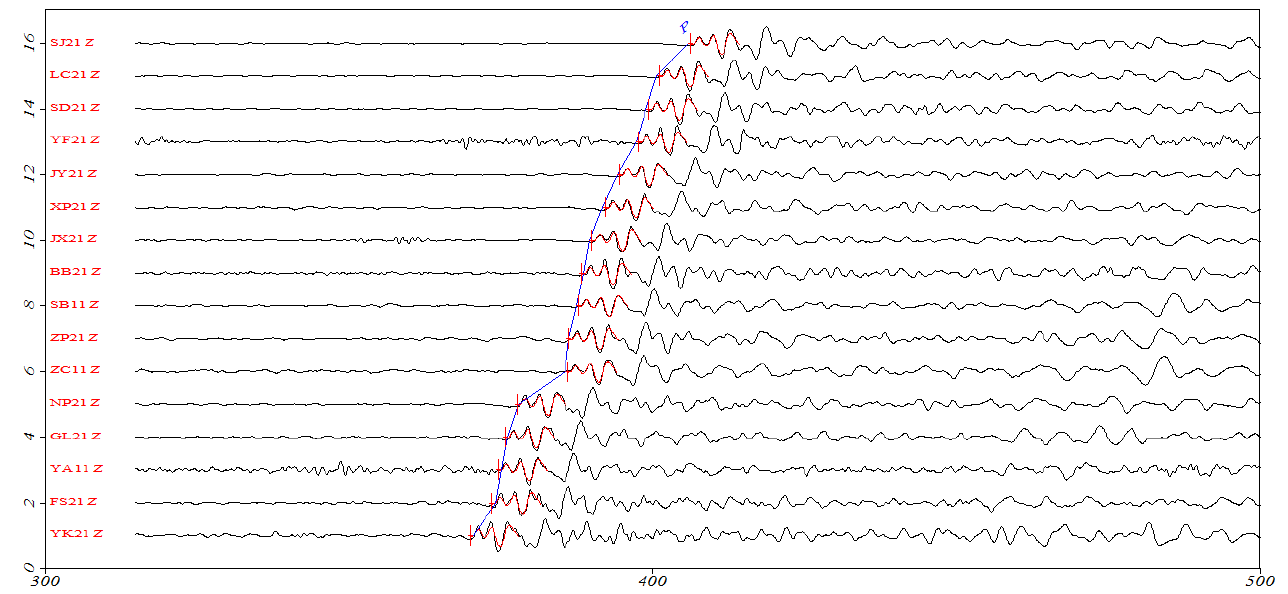
Figure 7. Correlation results of earthquake records in the Alo Islands.